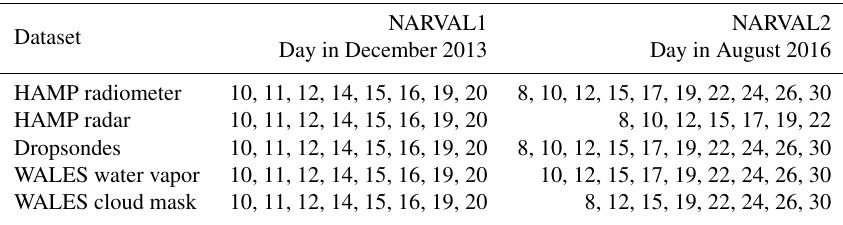
Table 1. Dataset availability. Days of research flights from which the datasets are used for the study of NARVAL1 and NARVAL2, respec-